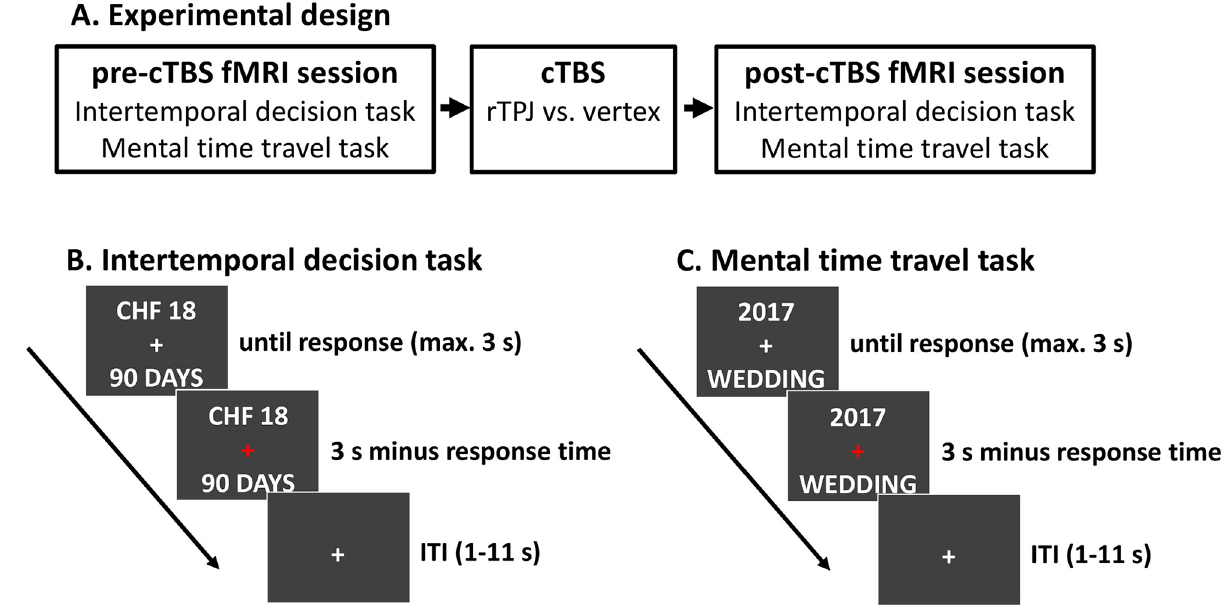
Fig 1. Experimental design and trial structure. (A) Participants performed an intertemporal decision task and a mental time-travel task in a pre-cTBS and a post-cTBS session in the MRI scanner. Prior to starting the post-cTBS session, participants received disruptive cTBS to either the rTPJ or the vertex as control site (between-group design). (B) The intertemporal decision task required choices between an SS option (10 Swiss francs today) and an LL option (10–20 Swiss francs delivered after a delay of 1–180 days). (C) In the mental time-travel task, participants judged whether personal (e.g., “my wedding”) or nonpersonal (e.g., “first man on Mars”) events occurred in the relative past or the relative future as judged either in the present (“2017”) or 8 years in the future (“2025”). cTBS, continuous theta-burst stimulation; rTPJ, right temporoparietal